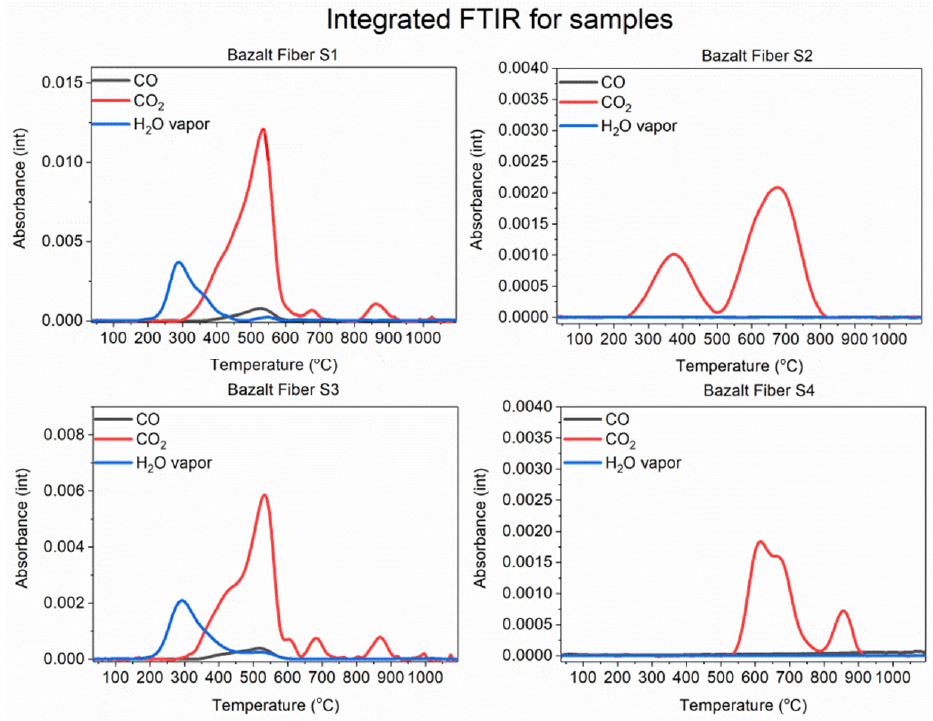
Figure 5. Integrated individual gases profiles for Basalt fibres 1–4 in an oxidising atmosphere. Table 1. Main thermochemical parameters obtained in experiments. For fibre samples that were in operation (Nos. 2 and 4) for TG-IR-Fourier from room temperature to 500 °C, a slight decrease in weight (from 0.2 to 0.4%) is observed, probably associated with the evaporation of a minimum amount of absorbed organic compounds from the environment. After reaching 500 °C, an increase in the mass of the sample prob- ably connected with processes of decomposition of the carbonate matrix and additional oxidation of oxides on the surface of the mineral fibre, which are overlapping on each other according to the results of IR-Fourier by CO 2 release.